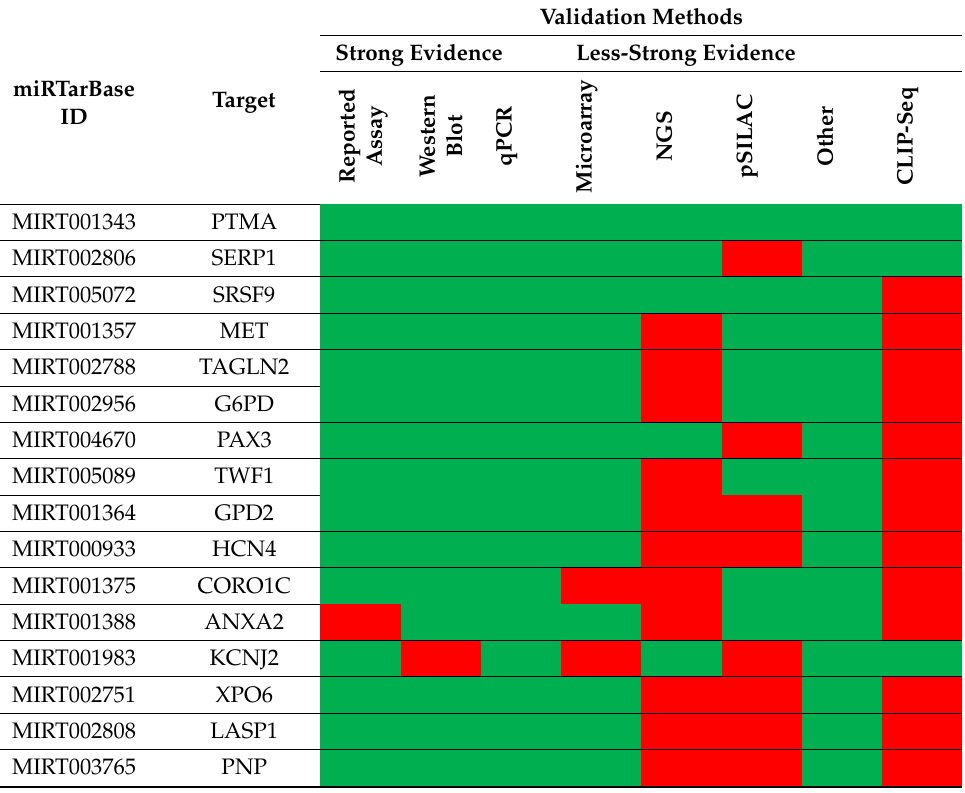
Figure 7. The regulatory network of hsa-miR-499a-5p and the SOX6 gene. Analyzing an hsa-miR-1-3p model with this tool, and analyzing the papers published concerning human studies, we obtained the results summarized in Table 6. Table 6. Summary of the miRNA interactions referred to hsa-miR-1-3p, supported with at least 5 positive methods; green = validated methods, red = unvalidated methods. The methods have been distinguished as strong or less-strong